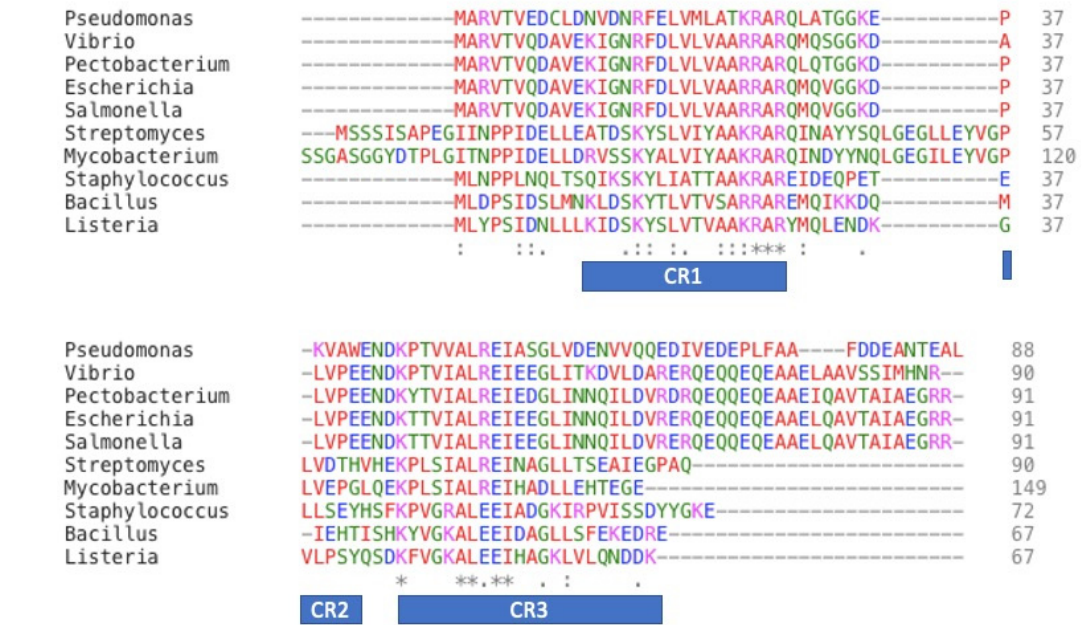
Figure 1. Sequence alignment of Gram-positive and Gram-negative bacterial ω . Identical residues are represented as (*), and similar residues are represented as (: or .). Several residues are highly conserved in both Gram-positive and Gram-negative bacteria like AAKRAR and ALEEI motif. Species names are, in order: Pseudomonas aeruginosa (RPOZ_PSEAB), Vibrio parahaemolyticus serotype (RPOZ_VIBPA), Pectobacterium atrosepticum (RPOZ_PECAS), Escherichia coli (RPOZ_ECOLI), Salmonella typhimurium (RPOZ_SALTY), Streptomyces coelicolor (RPOZ_STRCO), Mycobacterium tuberculosis (A0A0T9N9K3_MYCTX), Staphylococcus aureus (RPOZ_STAA9), Bacillus subtilis (RPOZ_BACSU) and Listeria monocytogenes serotype 4a (A0A0E0UX71_LISMM).